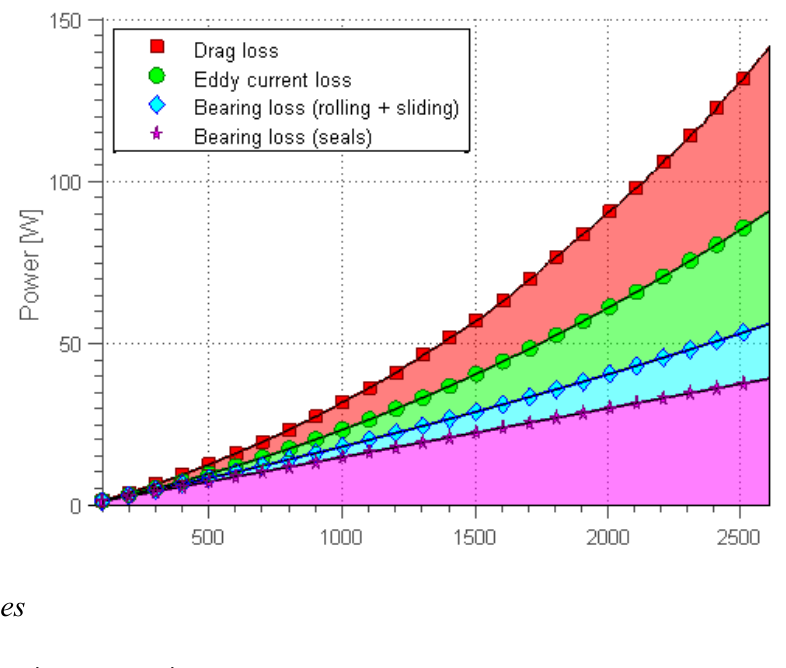
Figure 11. Decomposition of power loss using the dependence on rotational